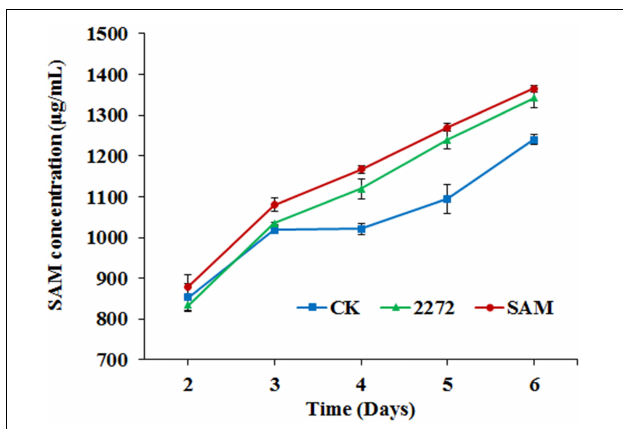
FIGURE 5 | S-adenosylmethionine accumulation in the fermentation broth of M. purpureus RP2 and M. purpureus 2272. CK, M. purpureus RP2 fermentation without addition of amino acid; 2272, M. purpureus 2272 fermentation without addition of amino acid; SAM, M. purpureus RP2 fermentation with the addition of 1 g/L SAM.